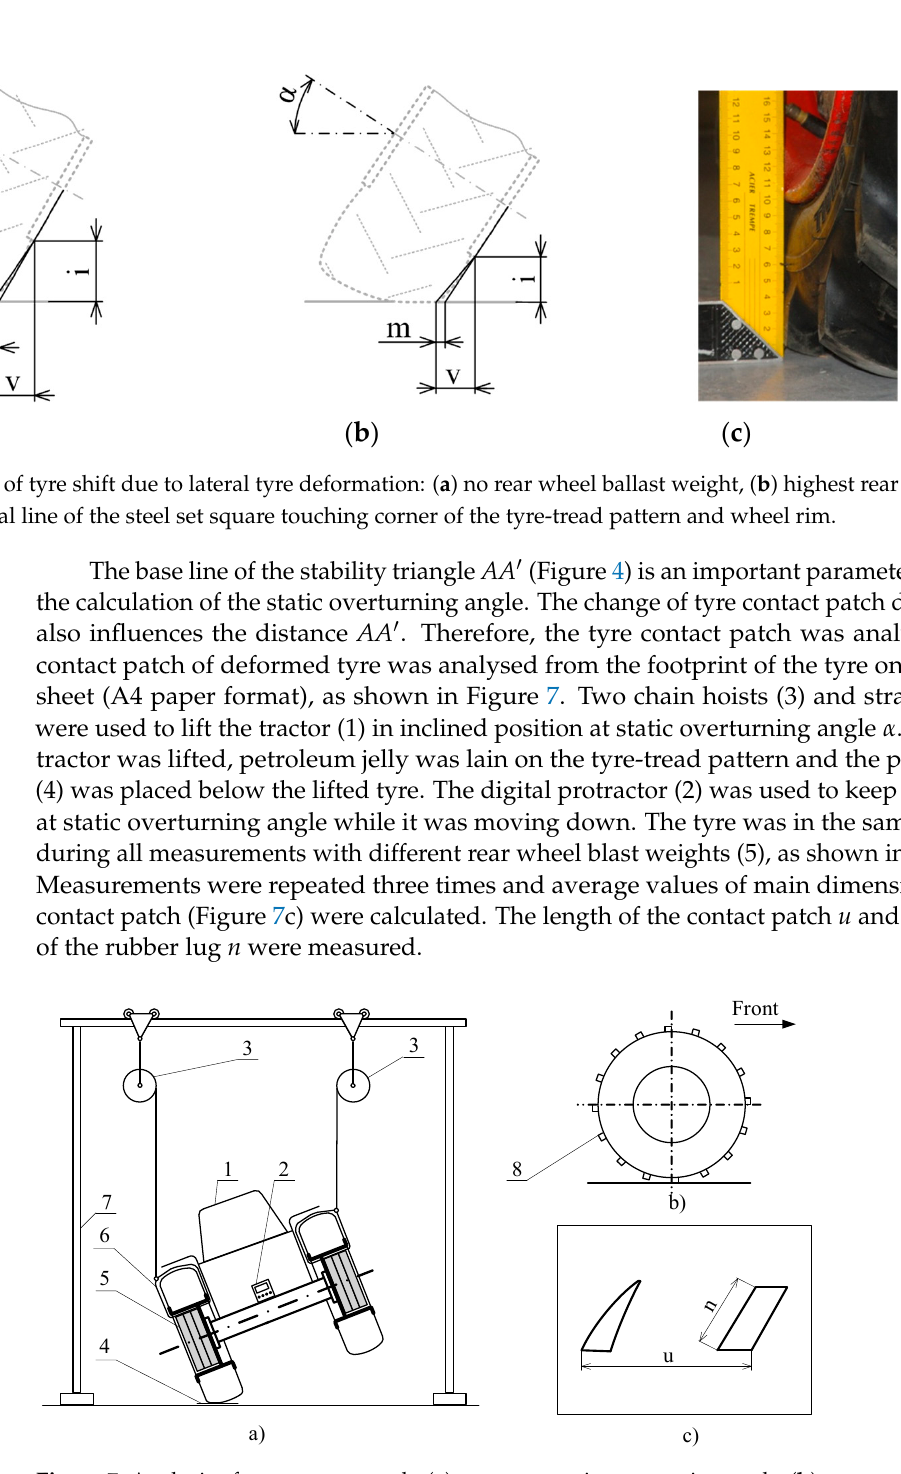
Figure 7. Analysis of tyre contact patch: ( a ) tractor at static overturning angle, ( b ) tyre position during experiments, ( c ) sketch of tyre contact patch on the paper sheet, 1—tractor, 2—digital pro- tractor, 3—chain hoist, 4—sheet of paper, 5—ballast weight, 6—strap belt, and 7—portal.